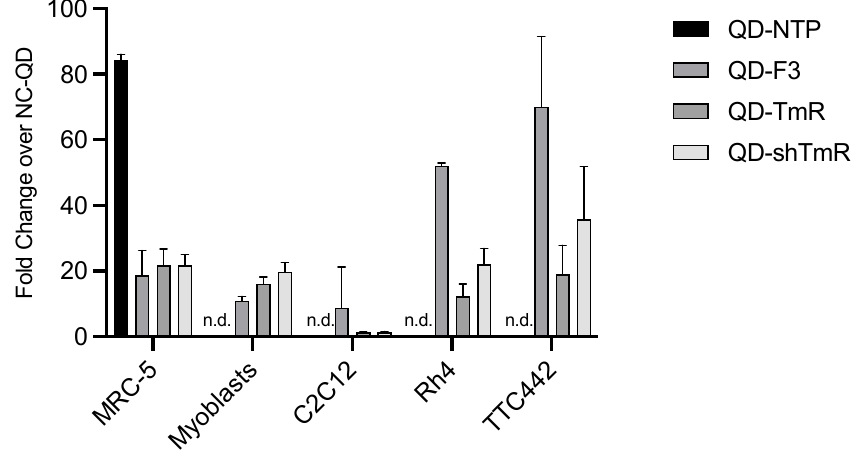
tested concentrations.